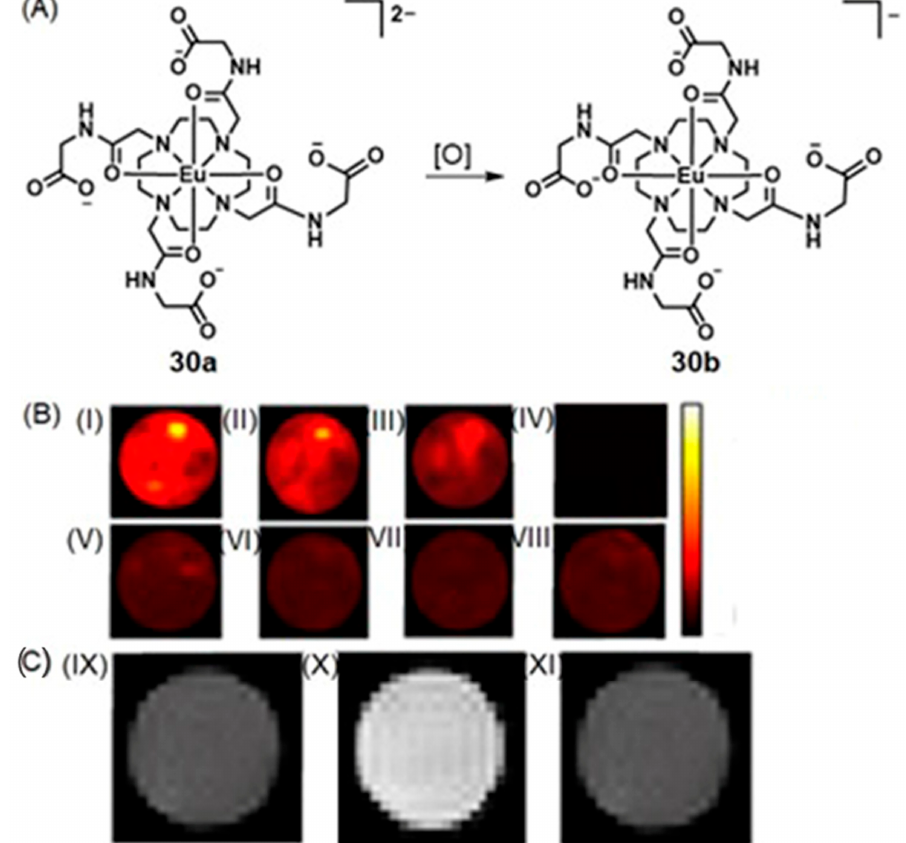
Figure 54. ( A ) Oxidation of 30a to 30b in the presence of oxygen. ( B ) Photoacoustic images of (I) 30a (100 mM in phosphate-buffered saline, pH 7.4); (II) 30a (60 mM in phosphate-buffered saline, pH 7.4); (III) 30a (30 mM in phosphate-buffered saline, pH 7.4); (IV) optical glass tube (wall thickness = 0.35 mm) containing distilled water; (V) 30b (100 mM in phosphate-buffered saline, pH 7.4); (VI) 30b (60 mM in phosphate-buffered saline, pH 7.4); (VII) 30b (30 mM in phosphate- buffered saline, pH 7.4); and (VIII) phosphate-buffered saline (pH 7.4). The color map represents the normalized intensity for photoacoustic images. ( C ) T 1 -weighted MRI of (IX) phosphate-buffered saline (pH 7.4); (X) 30a (30 mM in phosphate-buffered saline, pH 7.4); and (XI) 30b (30 mM in phosphate-buffered saline, pH 7.4). The tube diameters for MRI and photoacoustic imaging were 3 and 5 mm, respectively. Adapted with permission